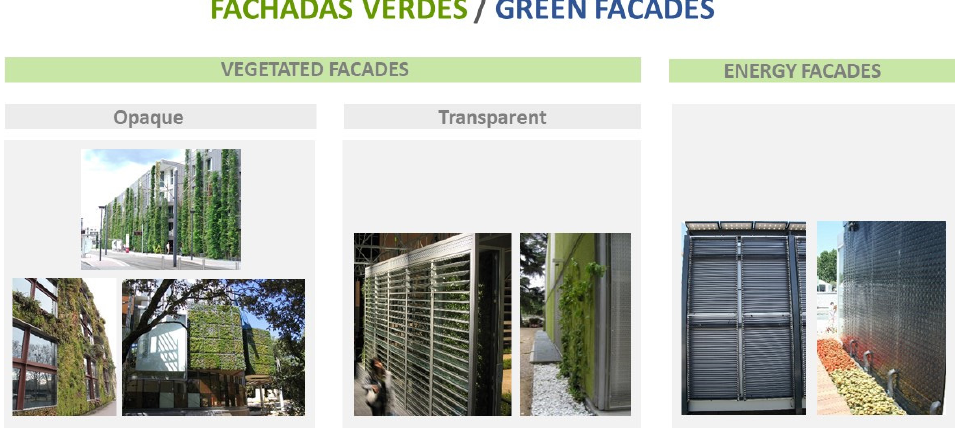
Figure A2. Types of green façades (table and images by the authors).